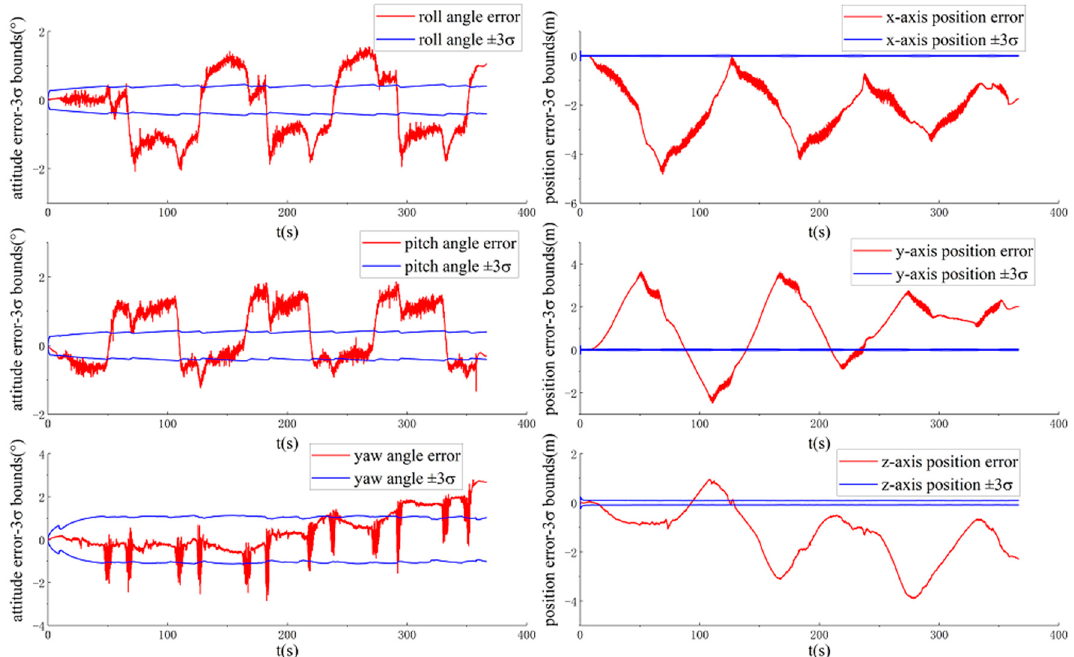
Figure 4. The ground-truth pose errors and estimated ± 3 σ bounds of ACK-MSCKF(1) with time for the VD06 dataset.